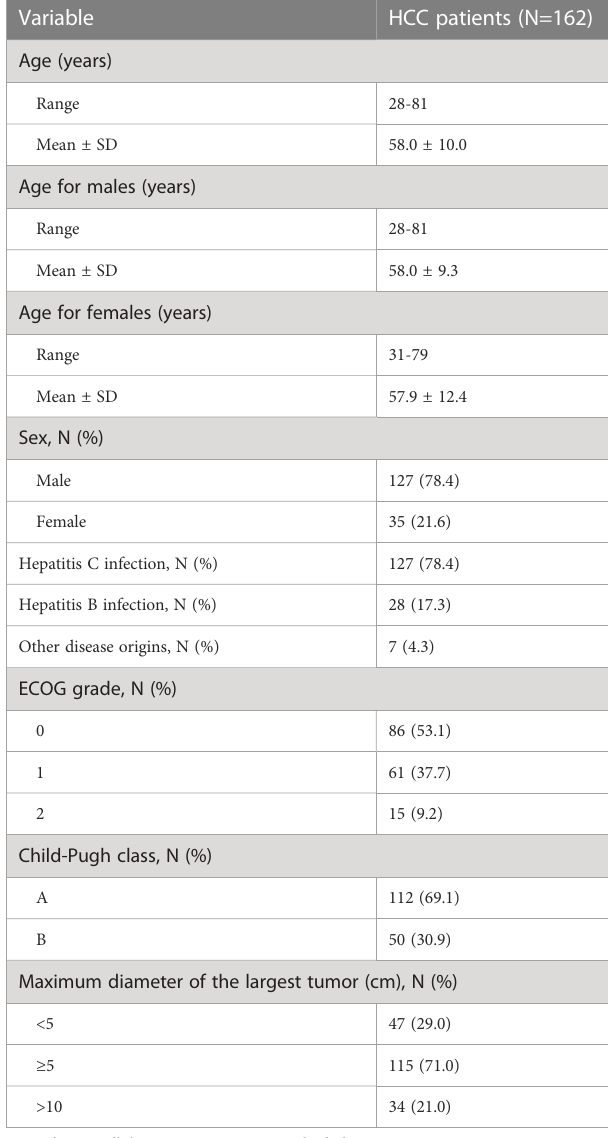
TABLE 1 Baseline characteristics of the study population.